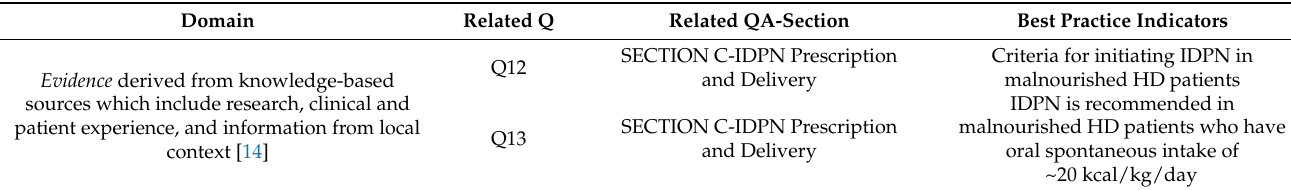
Table 1. IDPN Best Practice Indicators According to PARIHS